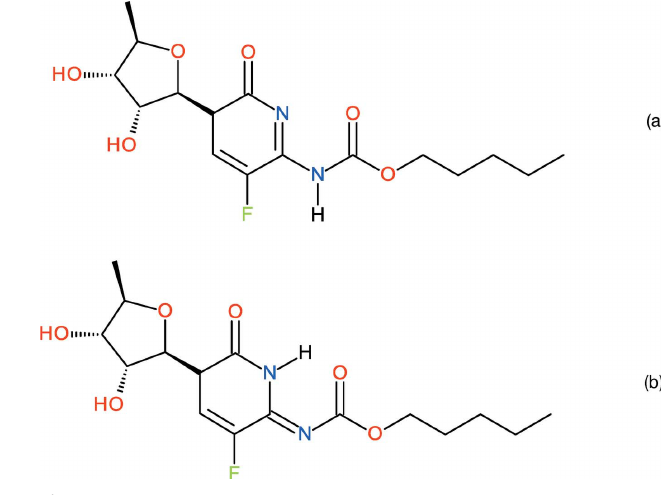
Figure 2 Schemes for the tautomeric forms of capecitabine ( a ) assumed in the powder-diffraction study and ( b ) established in the single-crystal study of Malinska et al.